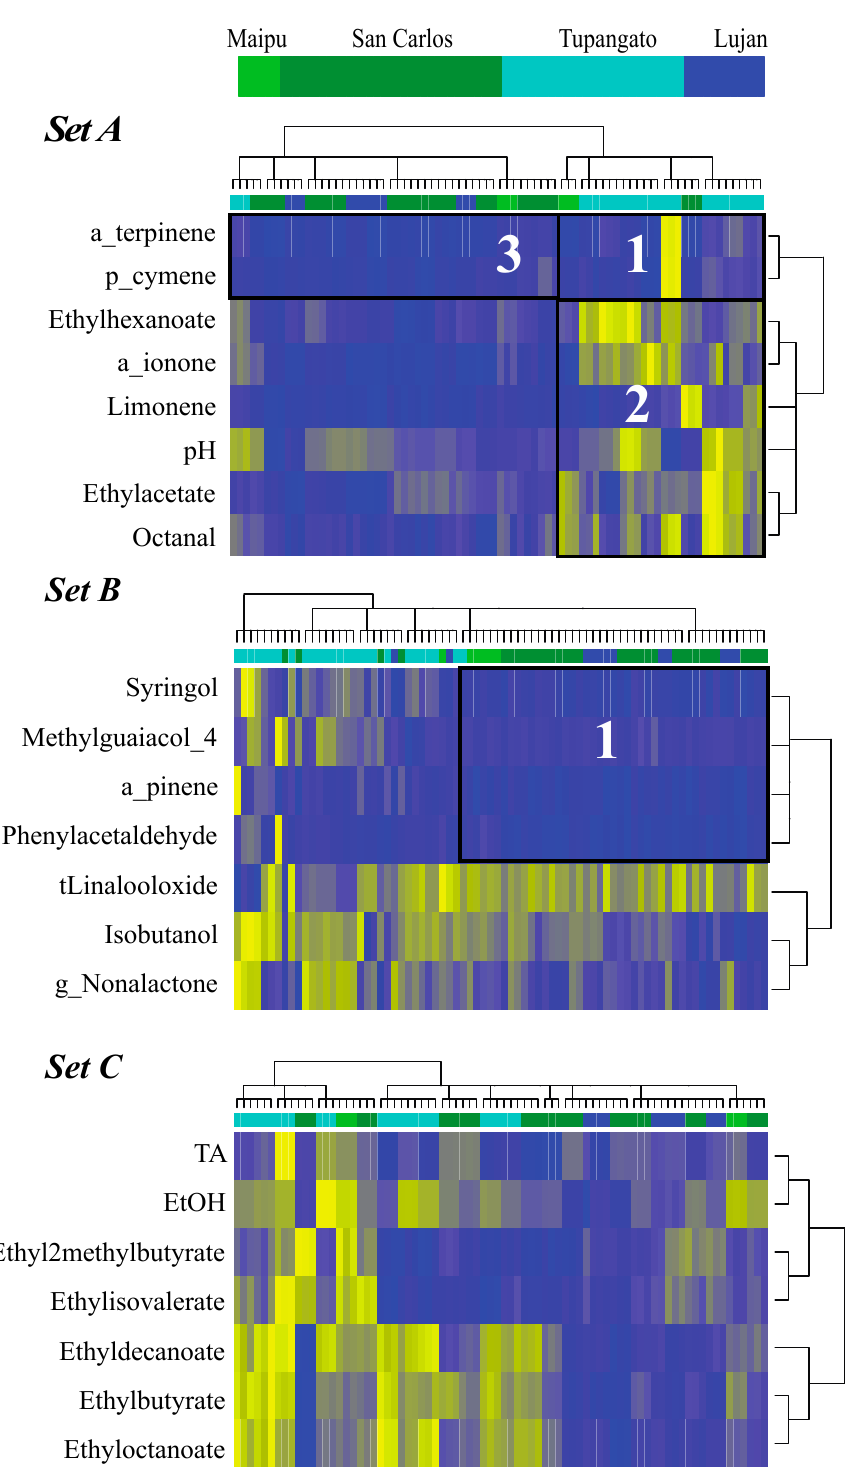
Figure 6. Clustering the Argentinean wines. The 78 wines are clustered using Data Mechanics on the three di ff erent sets of wine characteristics, ( A – C ) that are defined in ( A ). The corresponding heat maps have wines as rows, and wine characteristics as columns. The color scale blue to yellow used to represent the heat maps corresponds to the interval [1,10] for the digital scores (see text for details on those digital score, with blue mapping to 1 and yellow to